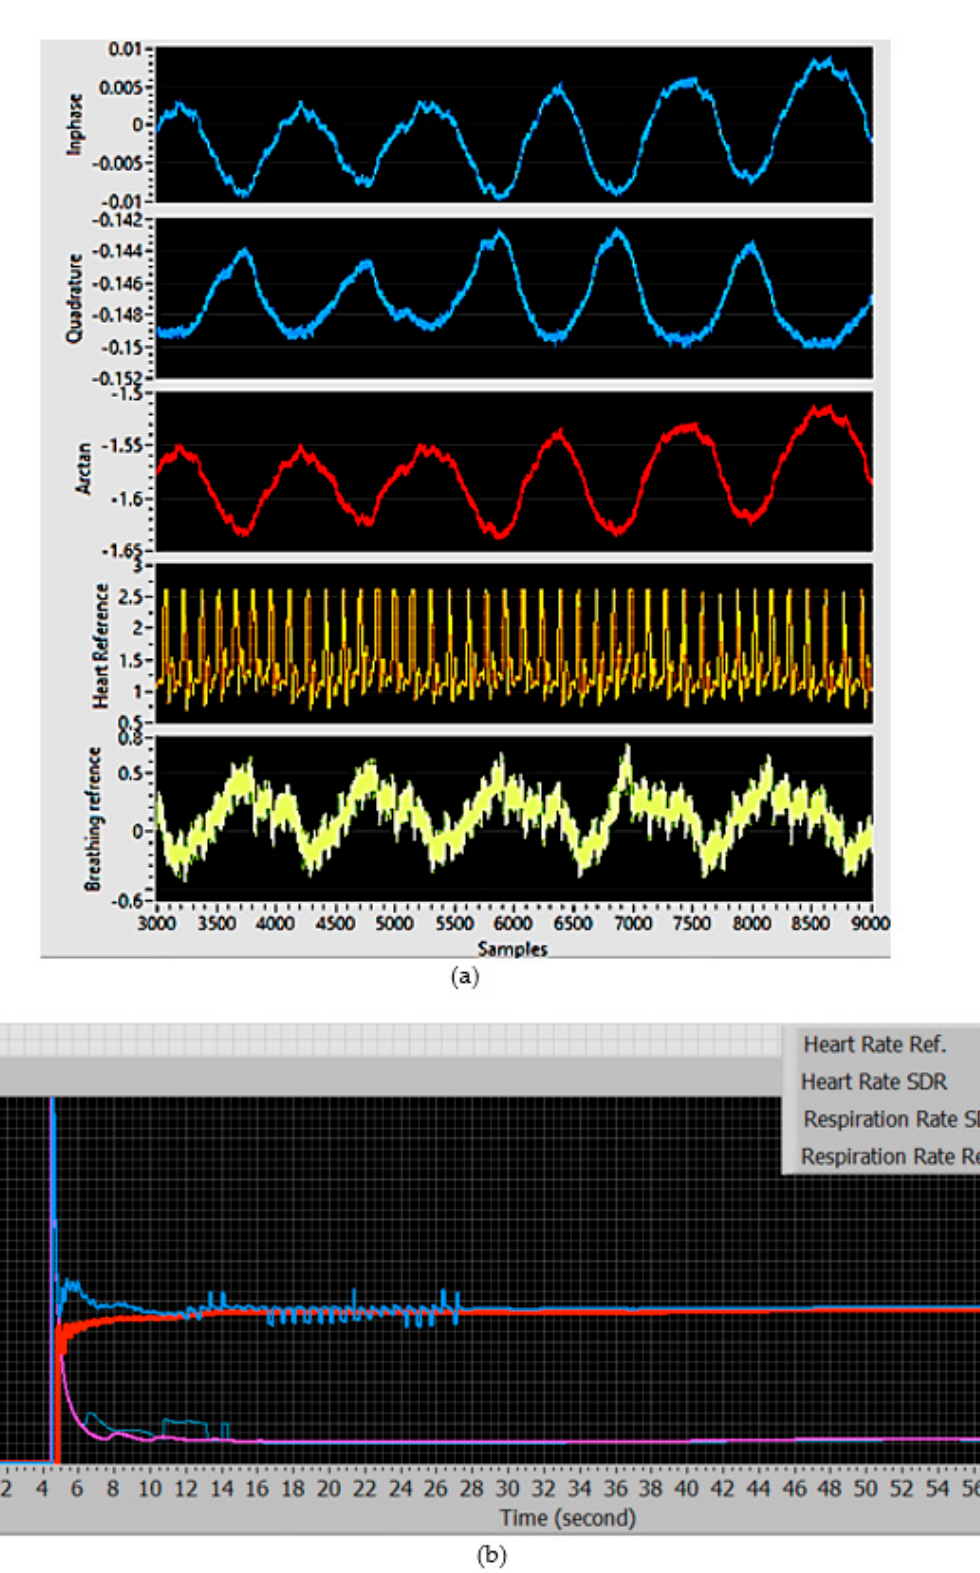
Figure 3. The core section of the GUI of the NCVS system: ( a ) I/Q/Arctan waveforms (top 3 channels) and the reference HR/RR signal waveforms (bottom 2 channels) all in the time domain; ( b ) the real − time NCVS system − measured HR/RR and the measured HR/RR from the reference sensors all plotted vs. time.